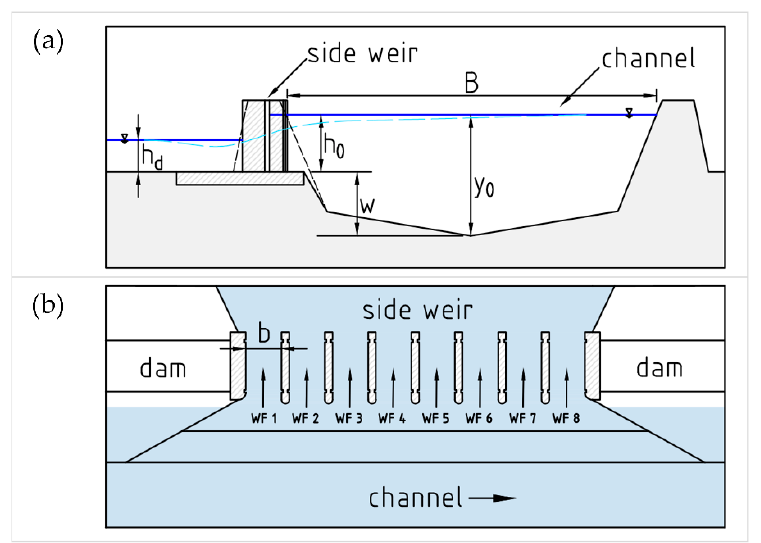
Figure 3. Schematic sketch of the side weir with eight weir fields—cross-section through the main channel and side weir ( a ) and plan view ( b ).